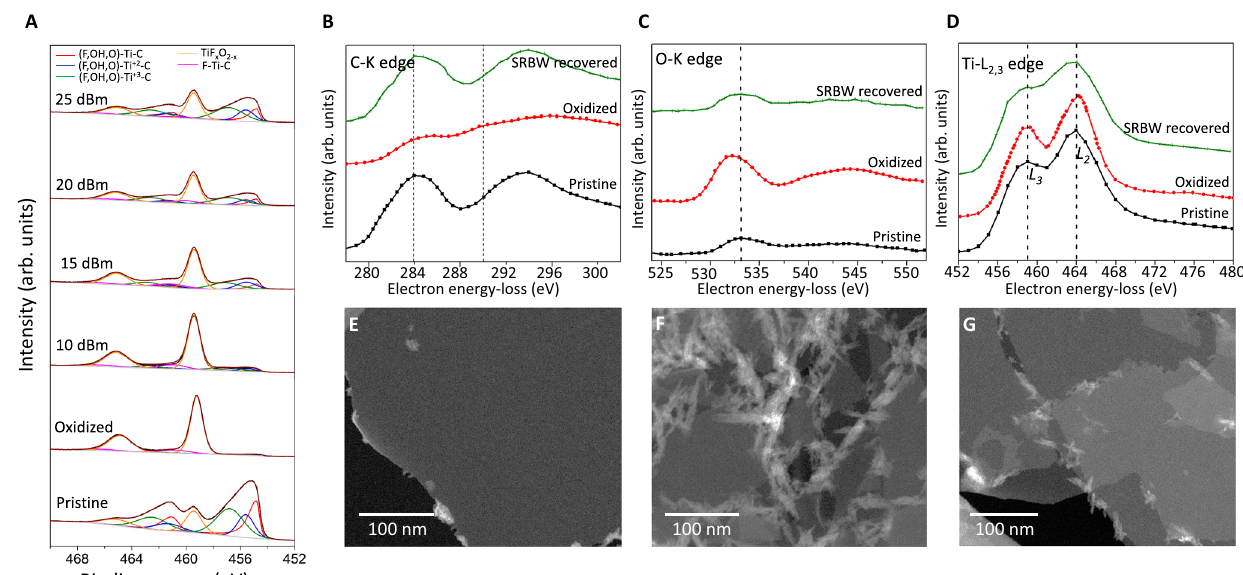
Fig. 3 |Chemicalcomposition. A X-ray photoelectronspectroscopy (XPS)spectra associated with the Ti 2 p region for the pristine, control (oxidized), and SRBW- recovered Ti 3 C 2 T z fi lms atincreasing powers; the curves were fi ttedfor the (F, OH, O) – Ti – C, (F, OH, O) – Ti 2+ – C, (F, OH, O) – Ti 3+ – C, TiF x O 2 − x , and F z – Ti – C species (Table S2, Supplementary Information). B – D Electron energy-loss spectroscopy (EELS)analysis(afterbackgroundsubtractionandpluralscatteringdeconvolution) of the pristine, control (oxidized) and SRBW-recovered (25 dBm) fi lms, with the